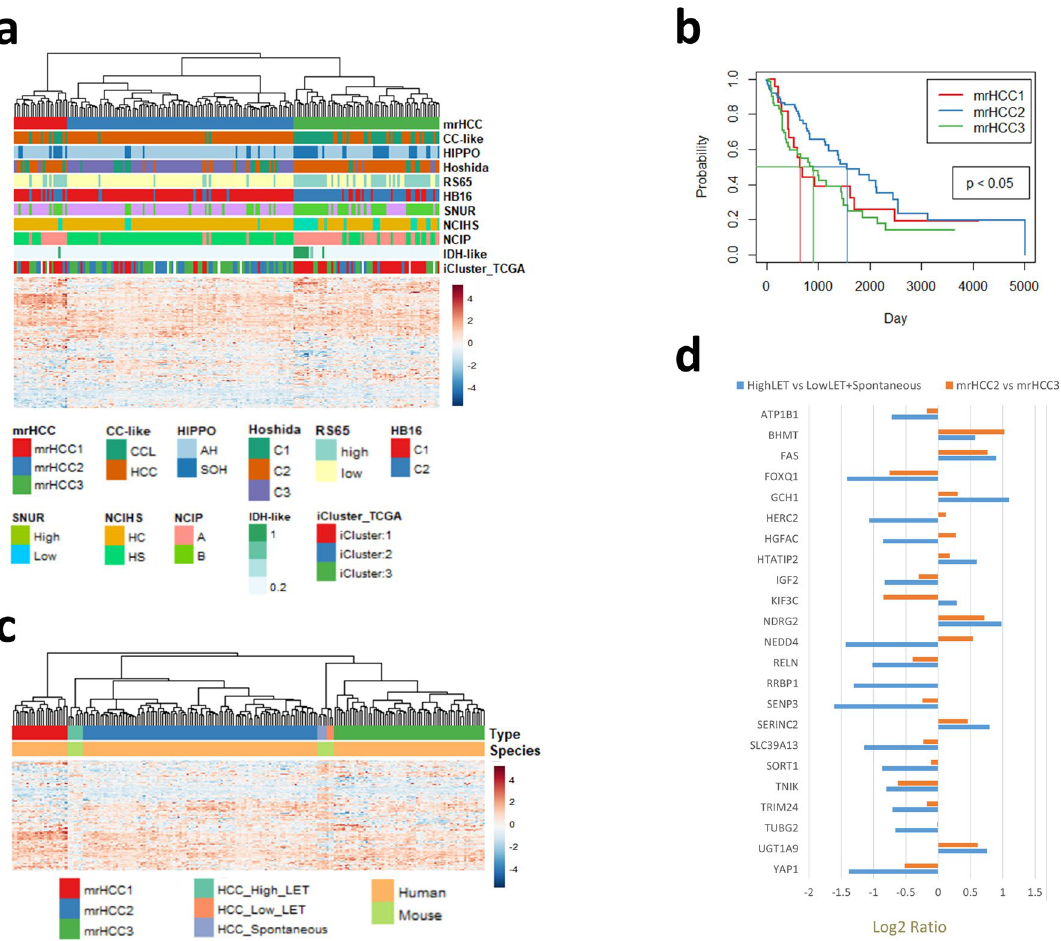
Figure 4. The mR-HCC gene set derived from the mouse HCC model identified subgroups of the human TCGA HCC cohort. ( a ) Clustering analysis of TCGA HCC samples using log2 ratios of mR-HCC genes. The clustering defined 3 clusters: mrHCC1, mrHCC2, and mrHCC3. Rows of annotations under the dendrogram are overlaid with molecular subtypes previously published by TCGA. ( b ) Kaplan–Meier analysis in human HCC based on mrHCC clusters. The survival probability differed significantly (p < 0.05) across the three clusters, with patients in the mrHCC2 subgroup showing better survival. Straight lines indicate median survival time in each mrHCC subgroup. ( c ) Clustering analysis of integrated mouse and human expression data using mR-HCC genes. High-LET radiation-induced mouse HCC samples were clustered in mrHCC2; low-LET radiation- induced and spontaneous mouse HCC were clustered in mrHCC3. Heatmap was plotted using log2 radios of gene expressions between tumor and normal liver. ( d ) Comparison of averaged expression ratios using a subset of mR-HCC genes identified as related to HCC via data mining of the published literature. The mouse expression ratios were high-LET vs. low-LET/spontaneous HCC samples; the human expression ratios were mrHCC2 vs. human mrHCC3